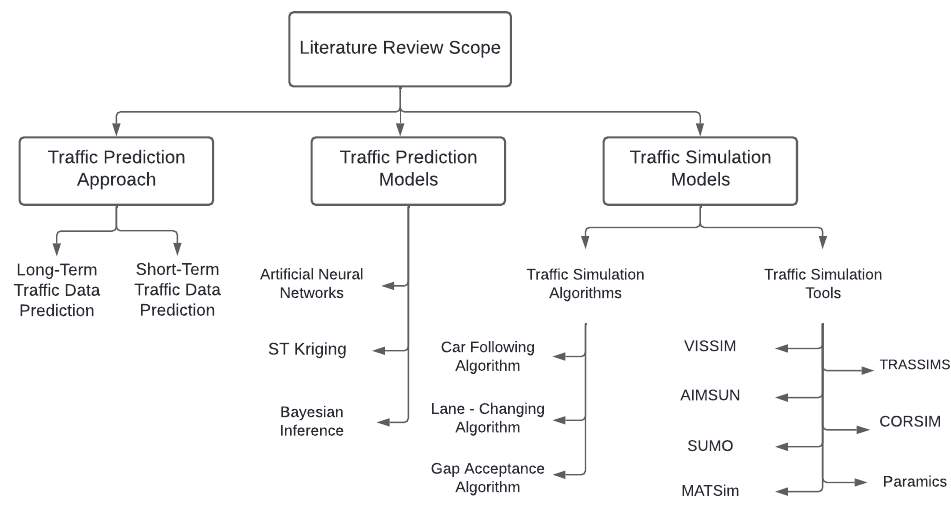
Figure 1. Structure of the